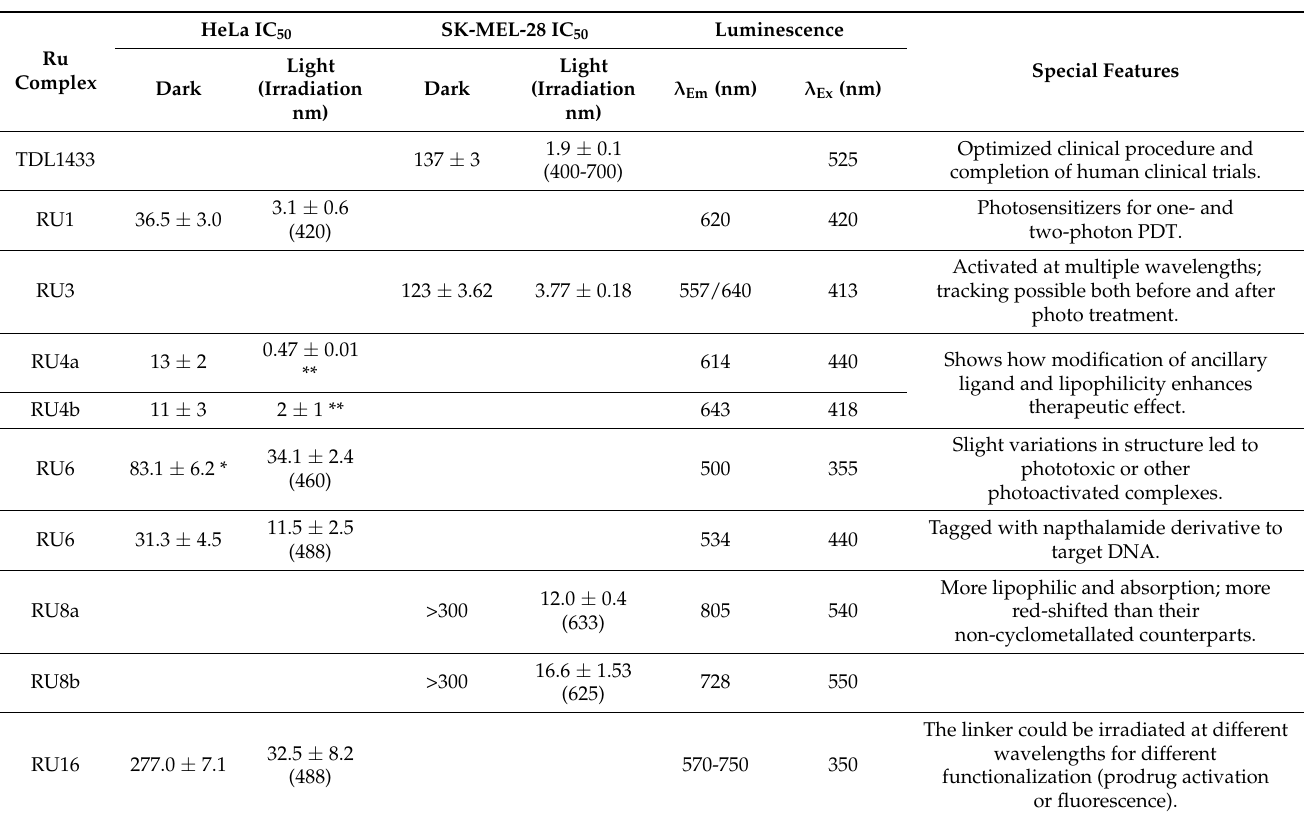
Table 2. A summary of the IC 50 values, luminescent properties, and special features of ruthenium(II) complexes: TDL1433, where NˆN = 44BPY [50]; similar complex RU1, where NˆN = BPY [52]; heteroleptic Ru(II) complex RU3 [54]; 21-carbon alkyl chain complexes RU4a, where NˆN = PHEN, and RU4b, where NˆN = TAP [55]; piano stool complexes RU5 [56] and RU6 [57]; cyclometallated complexes RU8a, where NˆN = 44BPY [59], and RU8b, where NˆN = BPY [60]; and Eu linked ruthenium complex RU16